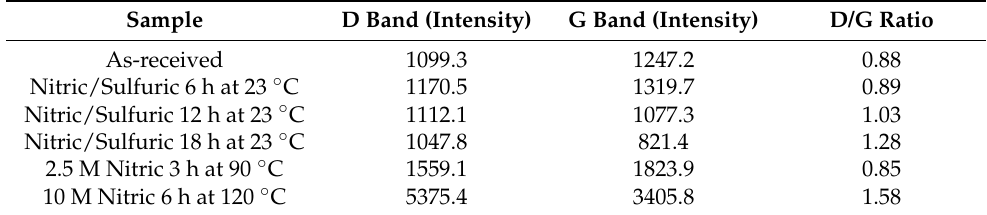
Table 5. Raman results for as-received and acid-treated carbon nanotubes.